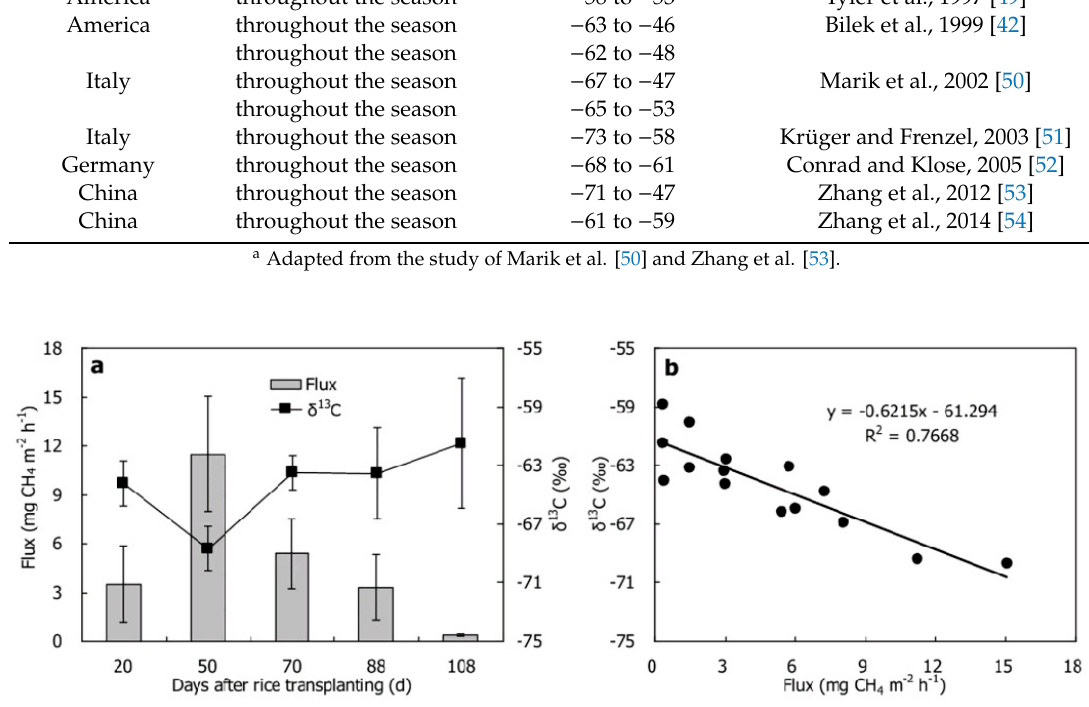
Figure 2. The relationship between CH 4 and δ 13 C in time evolution mode ( a ) and the correlation between them ( b ) (from Zhang et al. [37]).